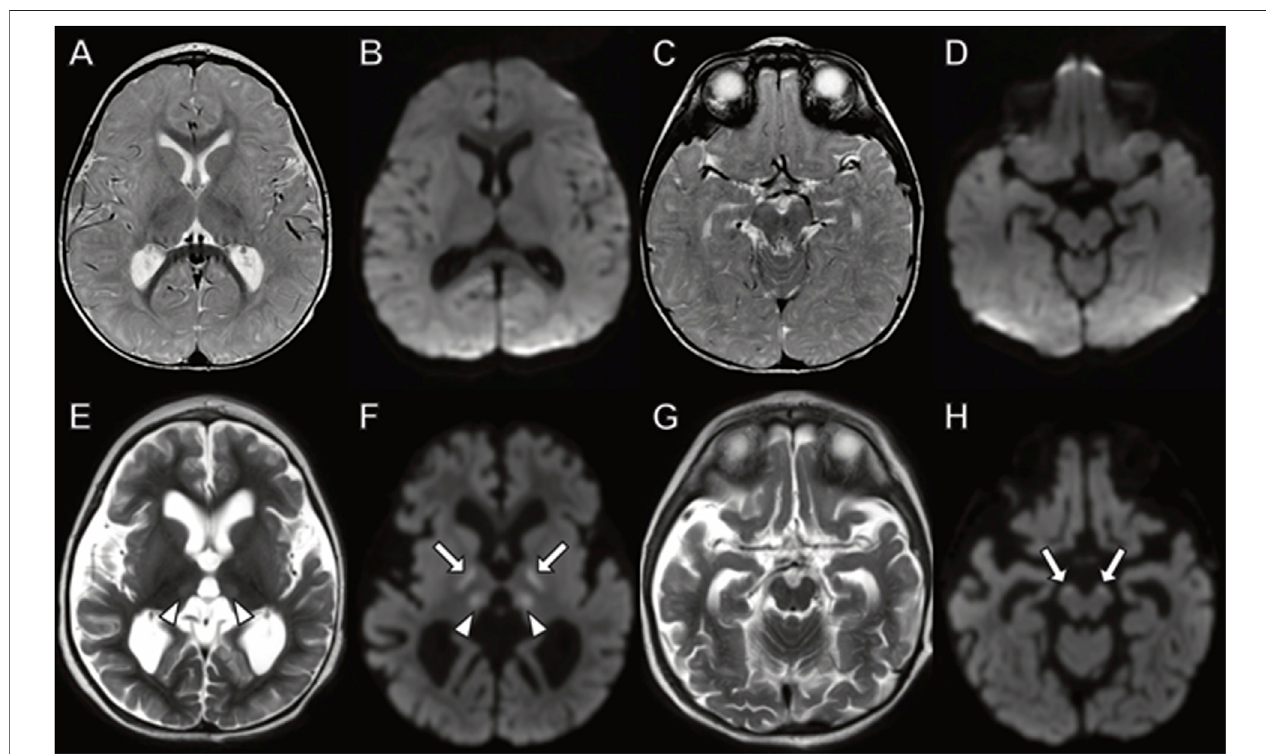
FIGURE6| BrainMRIinboywith TANGO2 mutationat (A – D) 8 monthsand (E – H) 15 monthsofage.ThebrainMRIat8 monthsdemonstratesnoabnormalsignal on (A,C) fl uid-attenuatedinversionrecoveryor (B,D) diffusion-weightedimages. (E – H) At15 months,diffusecerebralatrophyispresentwithabnormal (E) T2signaland (F) diffusion-weightedimaginghyperintensity inthethalamus(arrowheads). Additionalareasofrestricteddiffusioninvolvingthecorticospinaltracts ondiffusionweighted imaging ( (F,H) ,